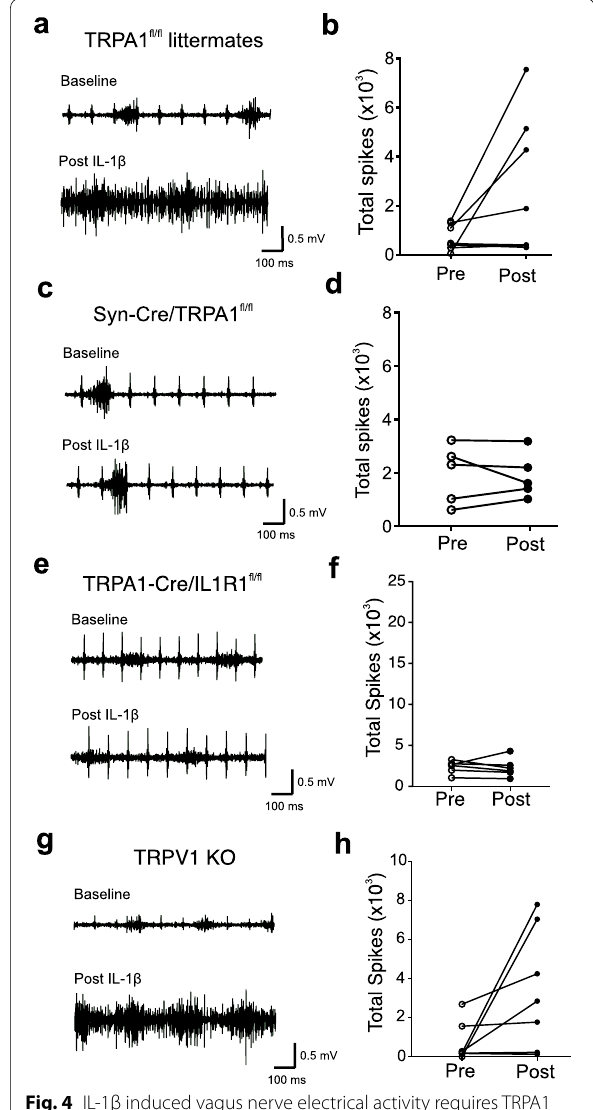
Fig. 4 IL-1β induced vagus nerve electrical activity requires TRPA1 and IL1R1 but not TRPV1. a , c Representative recordings of the vagus nerve signals shown for a TRPA1 fl/fl littermate control mice and c Syn-Cre/TRPA1 fl/fl mice starting before (baseline) and after